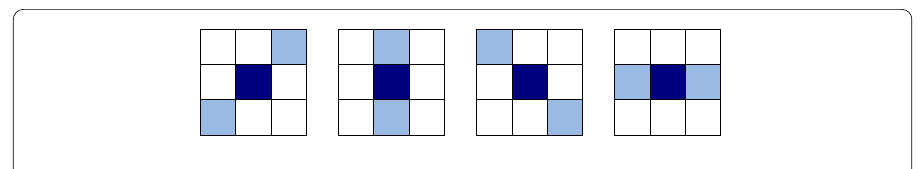
Figure 4 A discrete set of structuring elements B d with the origin at the center. Adapted from: